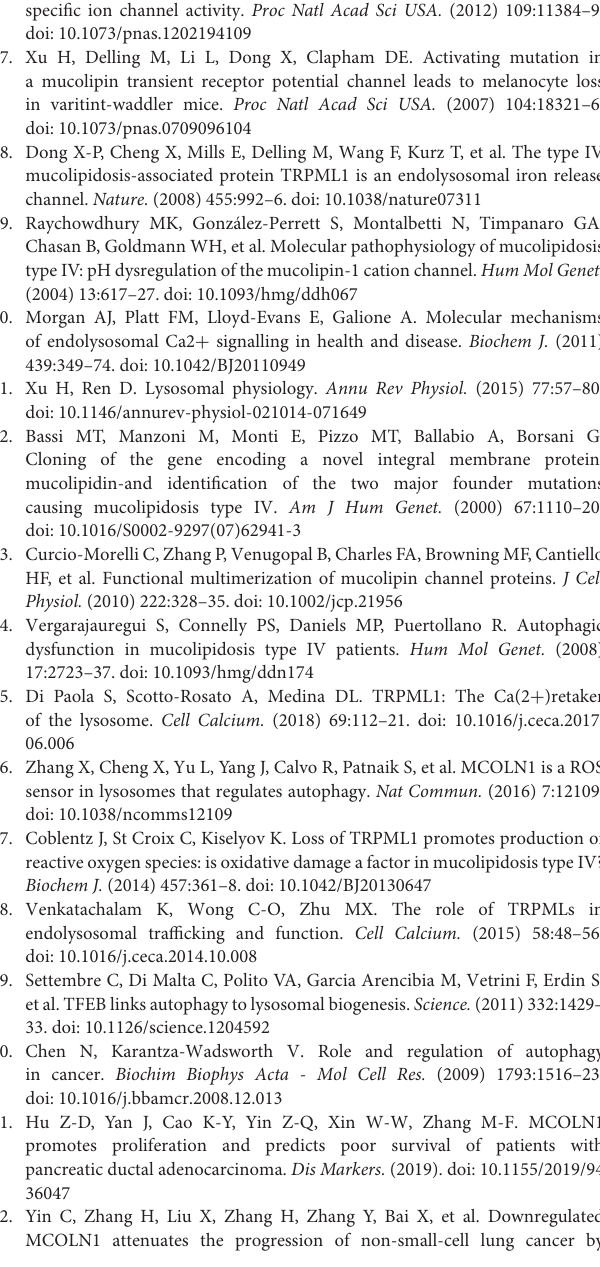
Supplementary Figure 1 | To analyze reactive oxygen species (ROS) production siGLO and siTRPML1, T98 and U251 cells were stained with dichlorodihydrofluorescein diacetate (DCFDA) before the flow cytometric analysis. Histograms are representative of one of three separate experiments. MFI, mean fluorescence